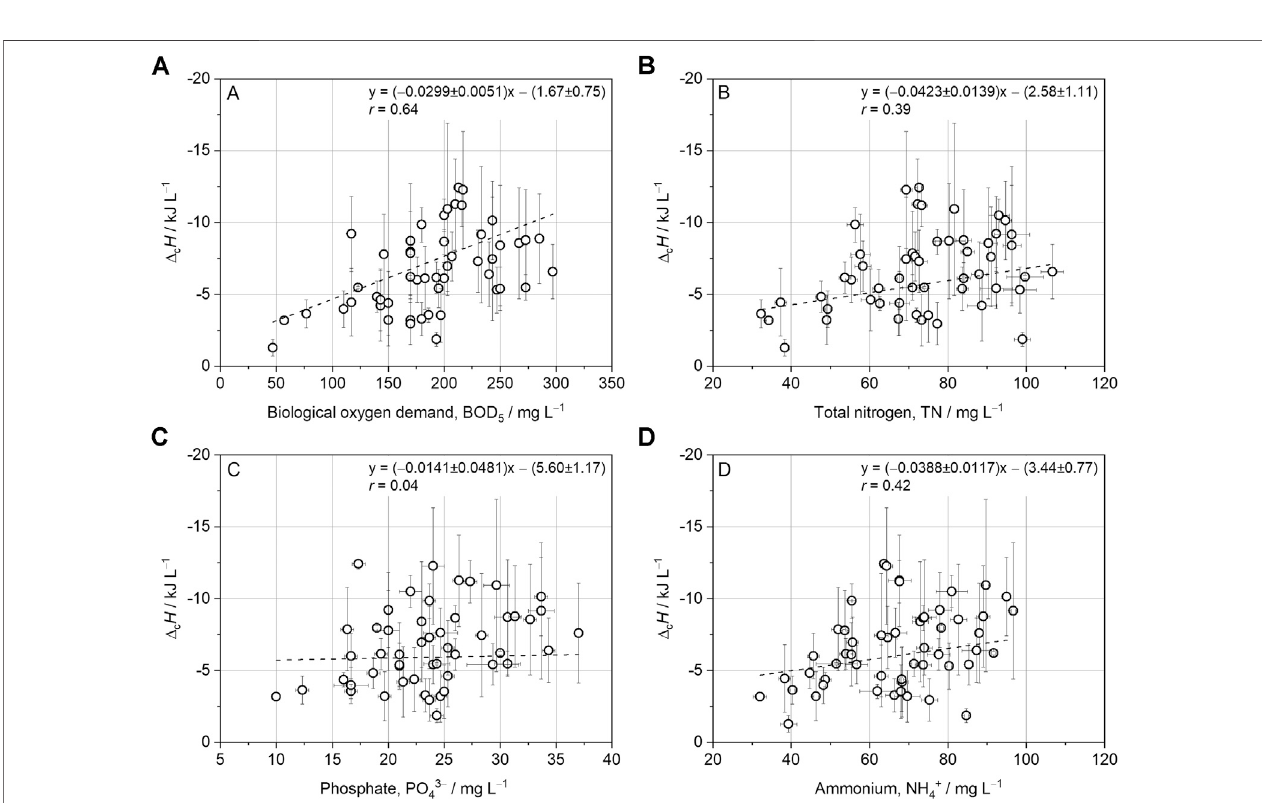
FIGURE 3 | Linear regression analysis with combustion enthalpy ( Δ c H ) derived from freeze-dried wastewater samples and (A) biochemical oxygen demand after fi ve days of incubation (BOD 43 − ), and (D) ammonium (NH 4+ ). Analysis was performed using composite samples ( n (cid:2) 53), 5 ), (B) Total nitrogen (TN), (C) phosphate (PO and error bars indicate standard